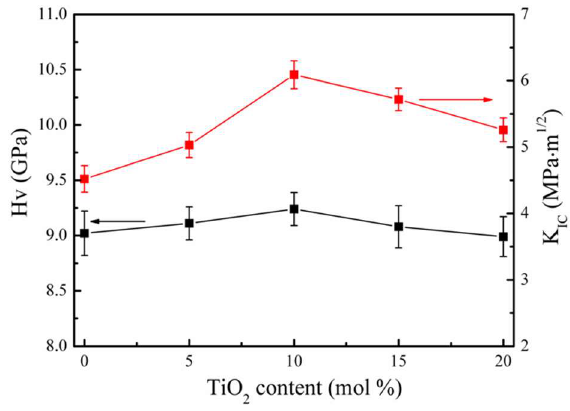
Figure 5. Vickers hardness and toughness of TiO 2 -doped ErSZ.